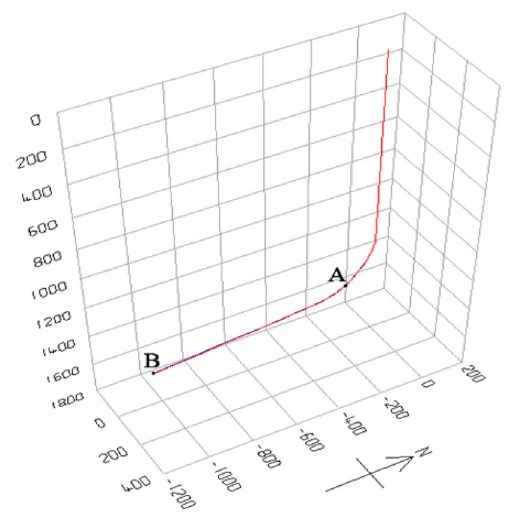
Fig. 17 Well trajectory achieved using the present algorithm against the design